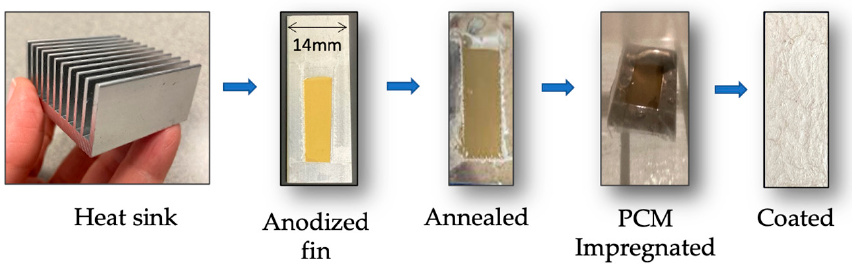
Figure 4. From left to right: Commercial aluminum heat sink employed; single fins were used for the initial proof of concept. The aluminum surface presented different surface finish and color as the samples undergo anodization, temperature treatment at 500 degrees C, were impregnated with PCM, and finally